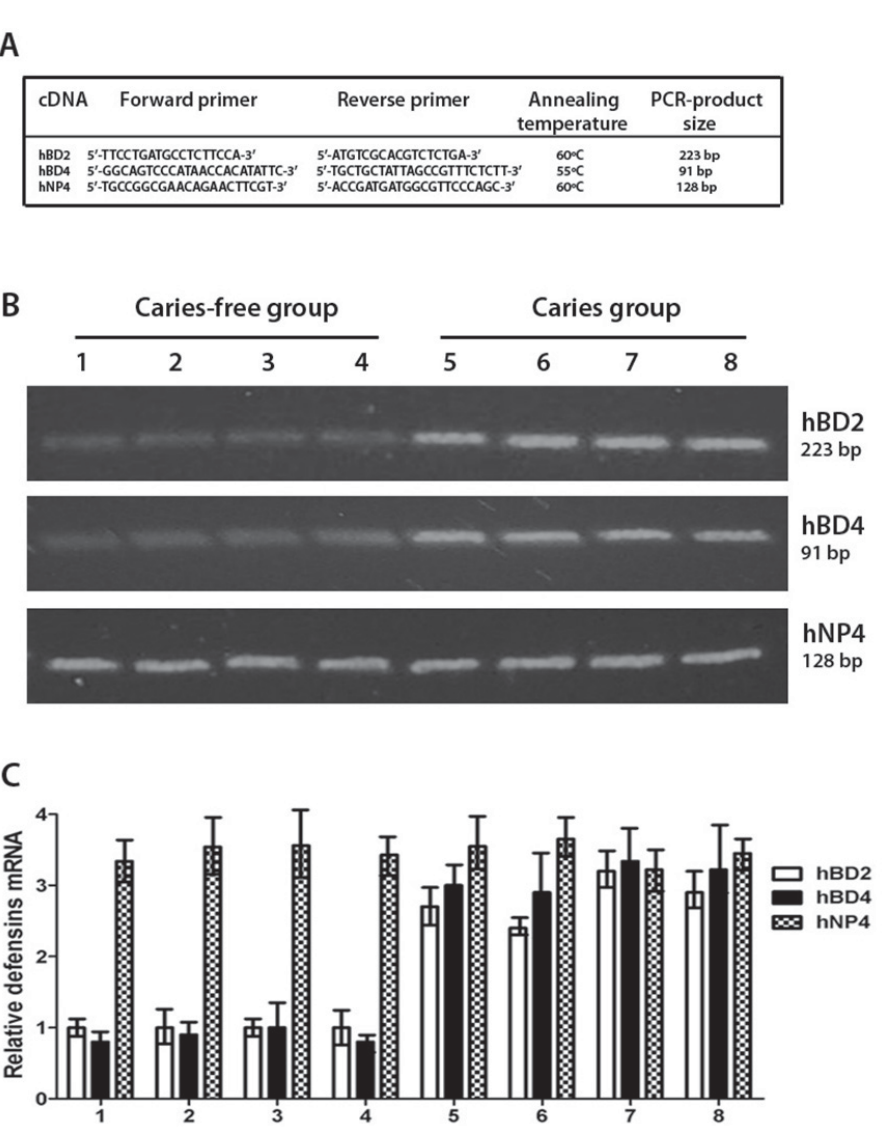
FIGURE 3. Quanti fi cation of differentially-expressed defensins mRNAs by RT-PCR. (A) Speci fi c primers and annealing tem- peratures employed. (B) RT-PCRs for hBD2, hBD4 and hNP4 were carried out from gingival samples divided in two main groups: caries-free (1-4) and caries (5-8). The PCR-products were run onto 2% agarose gel electrophoresis. Control reactions without reverse transcriptase were carried out. PCR was performed in a fi nal volume of 25 μ l containing 1 μ l of the reverse transcription reaction, 50 μ M of dNTPs, 1.5mM MgCl2, 50mM Tris–HCl (pH 8.0), 1 IU Taq polymerase and 0.2 μ M each of sense and antisense primers. Speci fi c PCR for a constitutively expressed gene ( β -actin) was carried out as a positive control (data no shown). The relative amount of product was quanti fi ed by densitometric analysis of DNA bands (C). Defensins-mRNA expression levels are shownnormalized to β -actin. Results are mean ± SEM of three independent